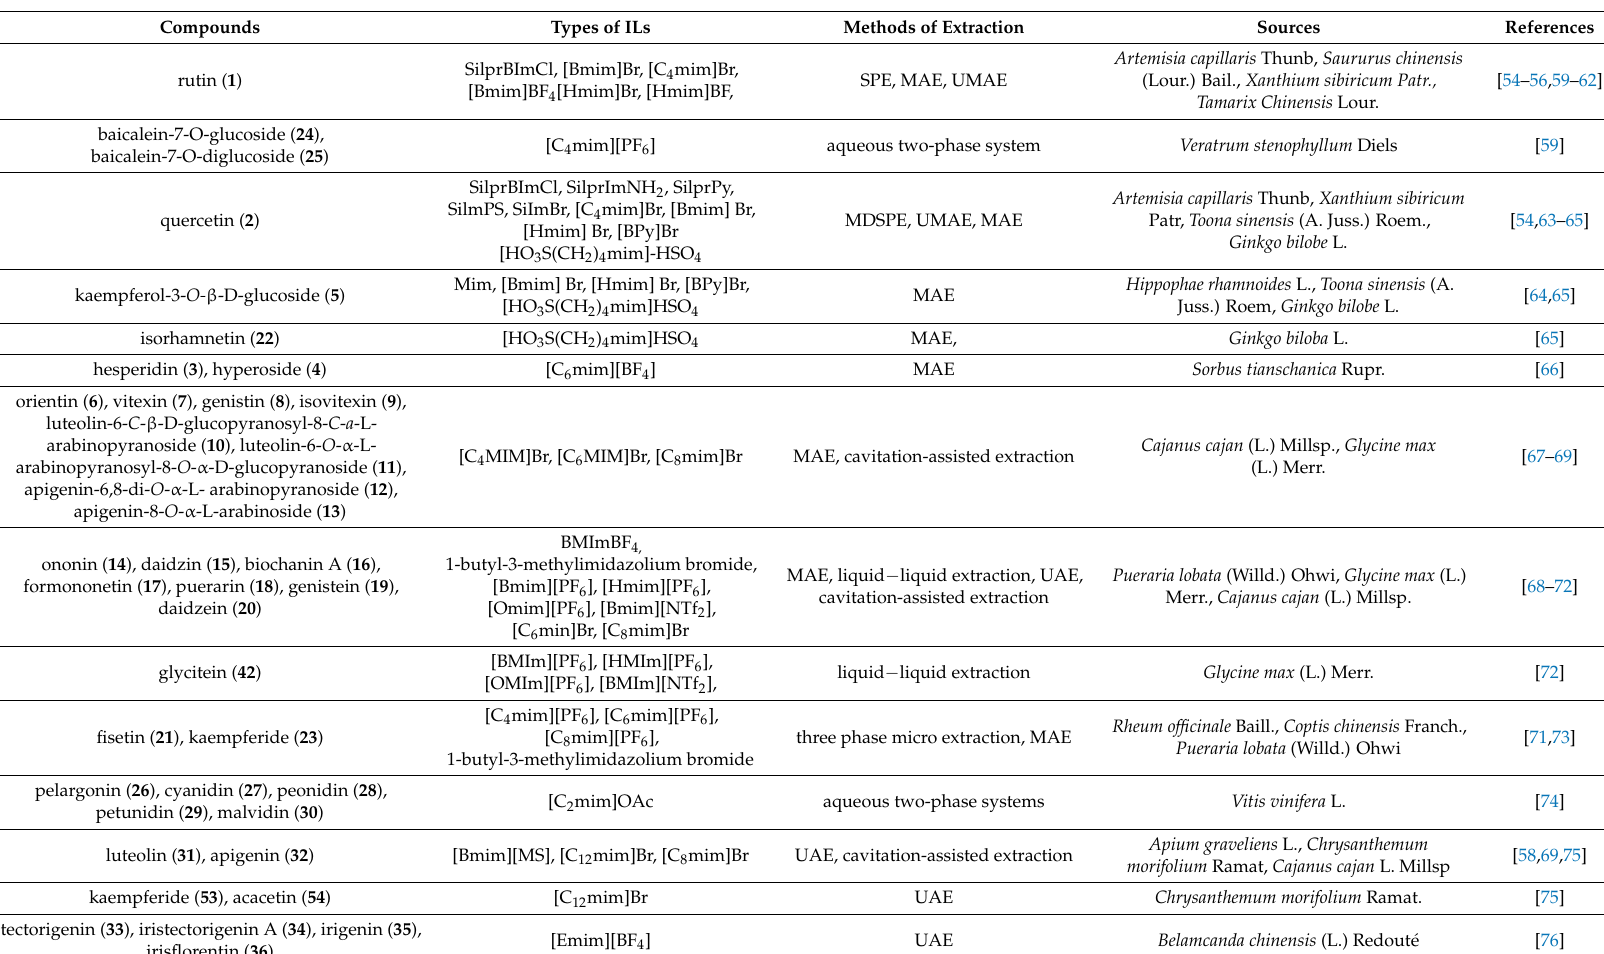
Table 4. The flavonoids extracted from natural sources using ILs or IL solutions by different extraction